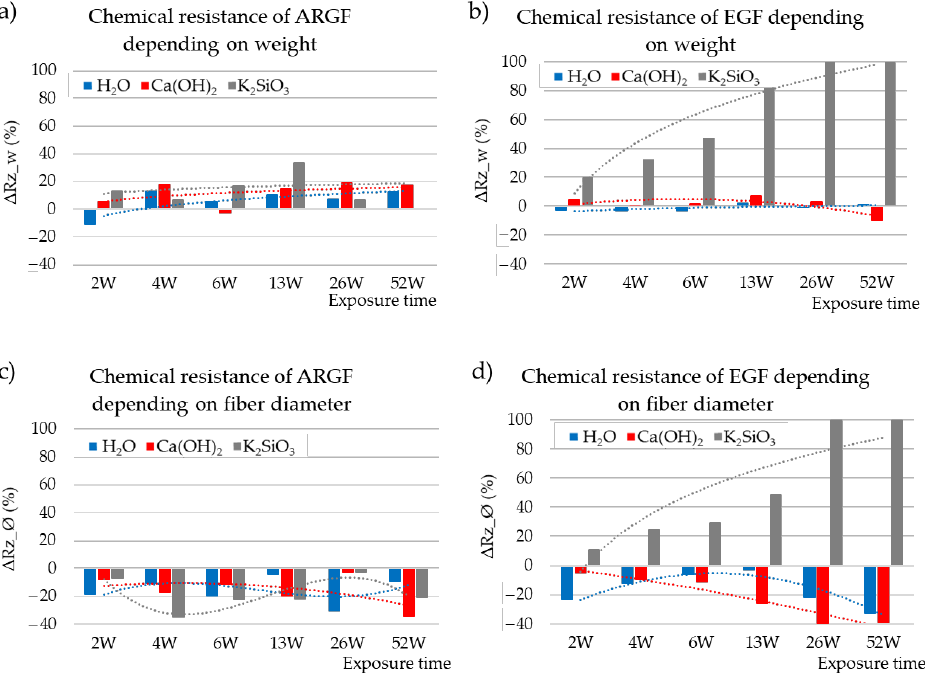
Figure 3. Chemical resistances of ( a ) ARGFs and ( b ) EGFs depending on weight ( ΔRz_w (%)) and chemical resistances of ( c ) ARGFs and ( d ) EGFs depending on fiber diameter ( ΔRz_Ø (%)).